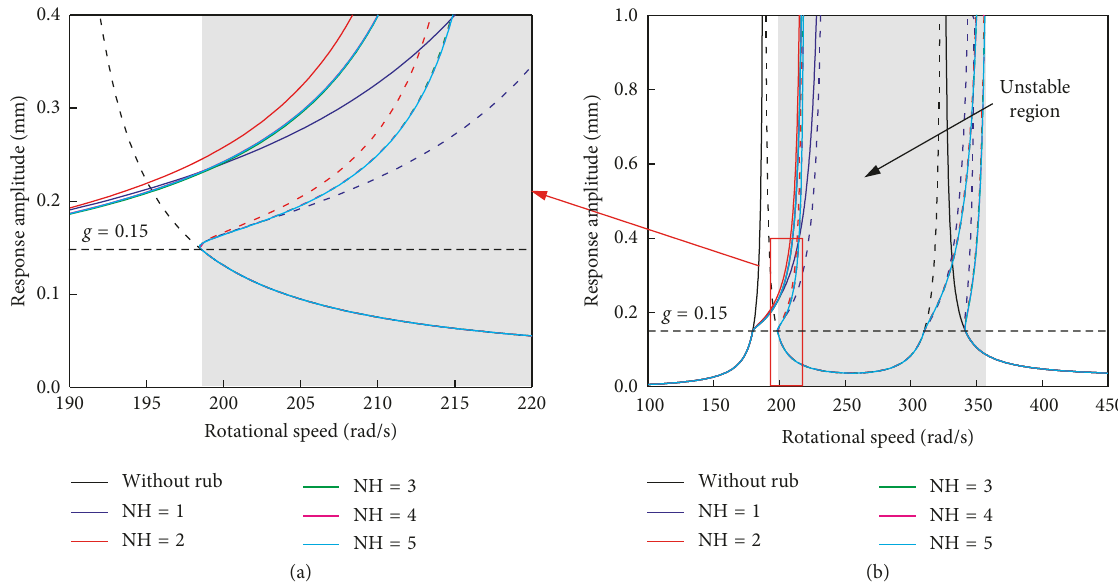
Figure 5: The horizontal amplitudes of disk node versus rotational speed of asymmetric rotor with rub-impact.